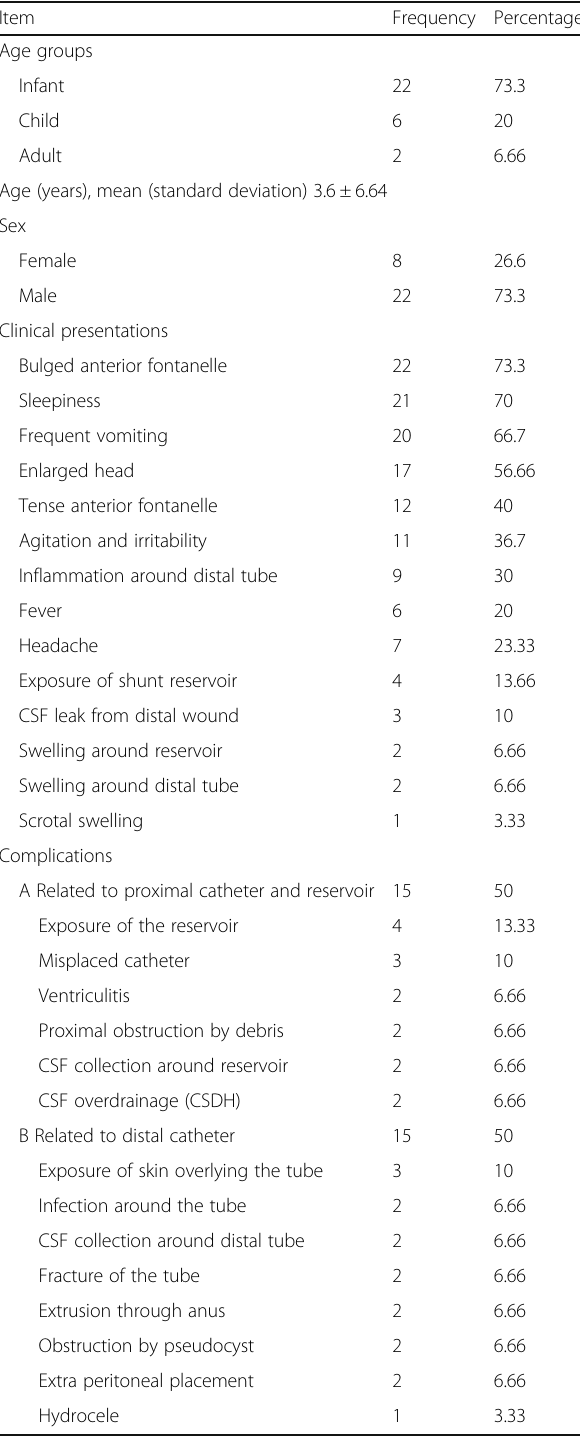
Table 1 Demographic data, clinical presentations, frequencies, and classifications of complications of